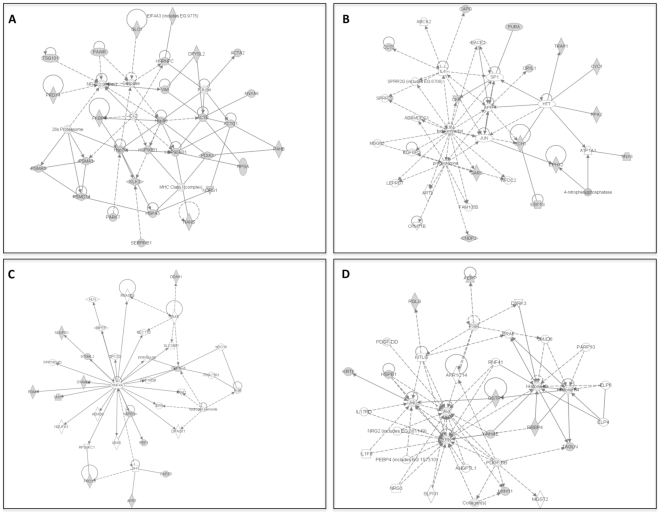
Protein subnetworks of differentially expressed proteins in PCa.(A–D) Protein-protein physical/functional interaction sub networks generated by Ingenuity Pathway Analysis tool. Grey filled boxes are the differentially expressed proteins. Only significant sub networks were shown in the figure.